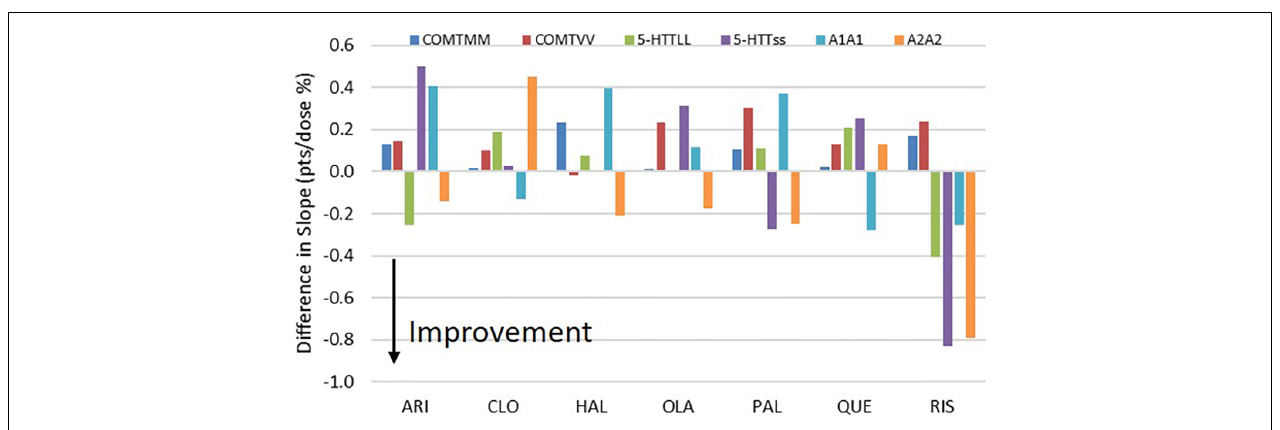
FIGURE 2 | Effect of COMT, 5-HTTLPR rs25531 and D2DRTaq1 genotypes on the slope of the PANSS Total dose-response for the range of doses associated with the different antipsychotics (number of points per 100% change in dose). The figure shows the differential effects of the homozygotes (for instance MM/*/* and VV/*/*) vs. the heterozygote subjects (for instance MV/*/*). All results are averaged over the 9 possible combinations of the other two genotypes with the appropriate distribution depending upon the frequency of the genotypes. Note that positive slope changes indicate that smaller doses are better, while negative slope changes indicate that larger doses are better. Like with the effects on the change in PANSS Total, the biggest effects for the most drugs are seen with the DRD2Taq1 allele, with the */*/A2A2 genotype favorable in drugs with strong D 2 R antagonism, but not in drugs with weak D 2 R antagonism (clozapine and quetiapine). The effect of the COMT genotype is limited, but the 5-HTT LPR genotype has only an effect with aripiprazole and risperidone. The size of the effect is limited; however, for instance the 0.5 effect on slope for */LL/* with aripiprazole translates to a 0.5 point improvement for a dose increase of 100% of the standard